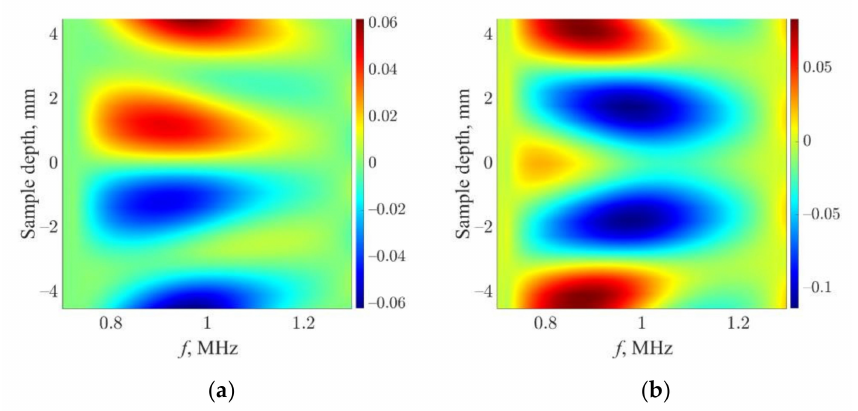
Figure 4. Particle displacement of S 3 mode across the thickness of steel plate versus frequency: ( a ) out-of-plane component; ( b ) in-plane